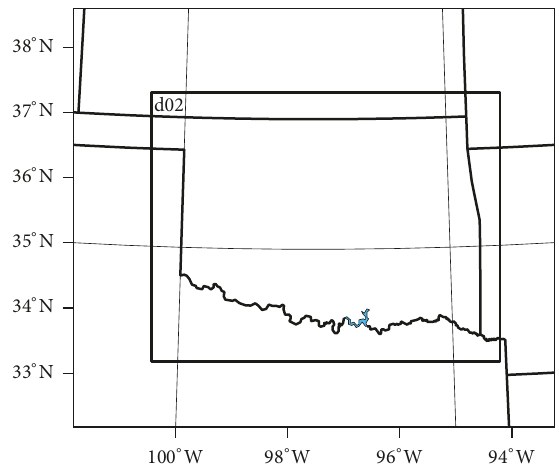
Figure 2: Map detailing the configuration of the nested domains used in